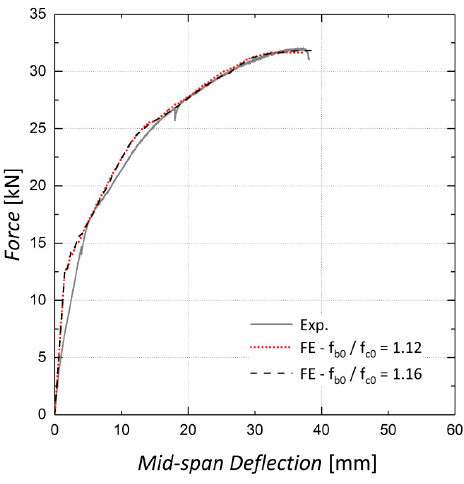
Figure 6. Sensitivity of results to f b0 / f c0 —Beam 10.